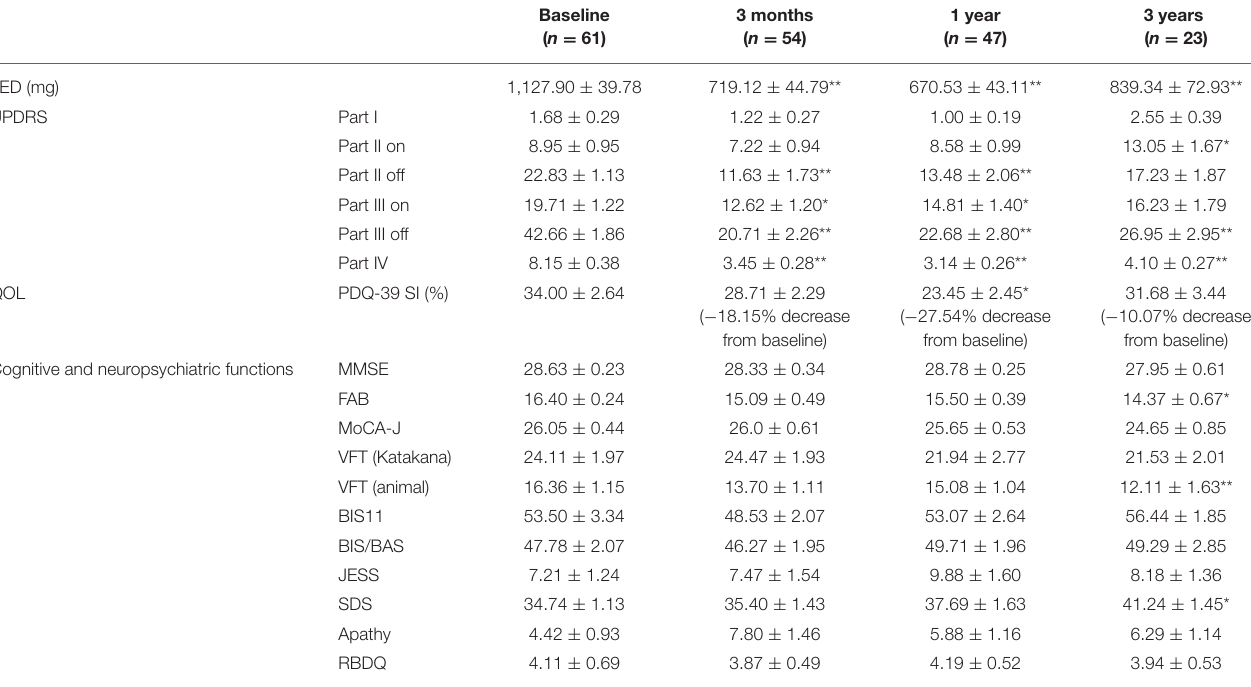
TABLE 1 | Temporal changes in levodopa equivalent dose, motor functions, cognitive functions, neuropsychiatric functions, and quality of life.